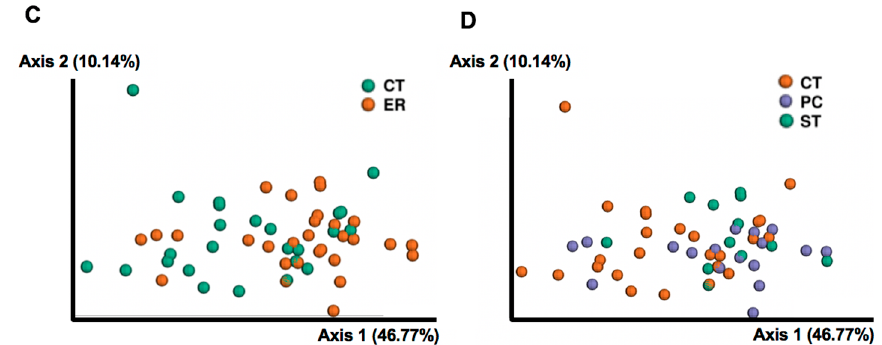
Figure 1. Comparison of bacterial diversity and communities between early rheumatoid arthritis patients (ER) and healthy controls (CT). ( A , B ) Faith’s phylogenetic diversity comparisons were performed for ER and CT groups using Wilcoxon rank-sum tests. Comparisons among CT, PC, and ST groups were performed using Kruskal–Wallis tests. Lines inside the box represent the median, while whiskers represent the lowest and highest values within the 1.5 interquartile range (IQR). Outliers and individual sample values are shown as dots. ( C , D ) Principal coordinate plot based on the weighted-UniFrac distance matrix.